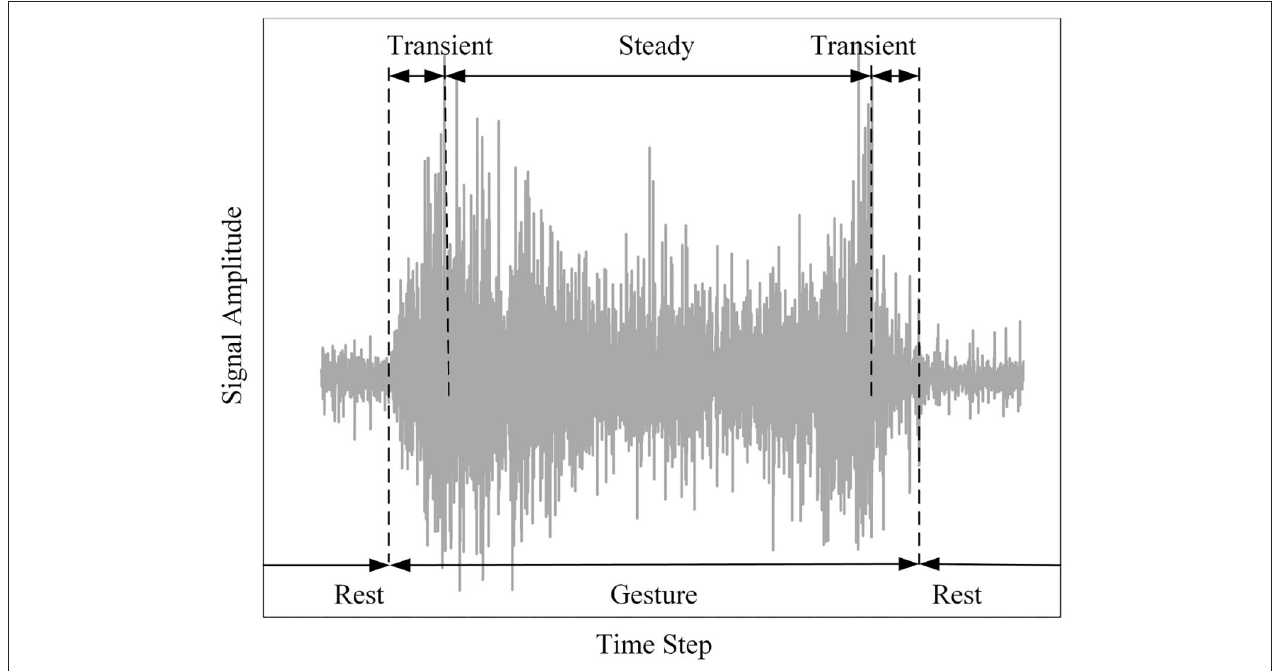
FIGURE 1 | The surface electromyography (sEMG) data of a